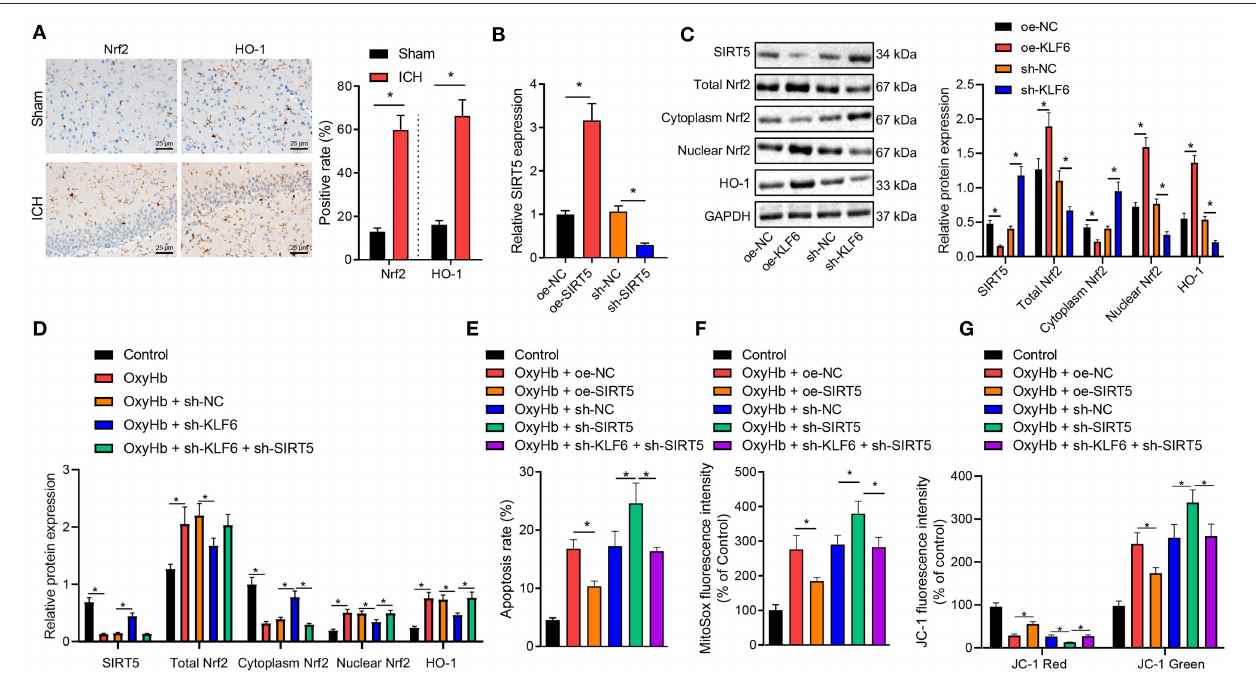
FIGURE 7 | Silencing KLF6 causes inhibition of mitochondrial ROS and mitochondrial damage of OxyHb-induced hippocampal neurons via the SIRT5/Nrf2/HO-1 axis. (A) The expression of Nrf2 and HO-1 in the hippocampus of ICH rats detected by IHC ( n = 6). (B) The expression of SIRT5 in hippocampal neurons after the silencing and overexpression of SIRT5 determined by RT-qPCR. (C) The expression of SIRT5, Nrf2 (total, cytoplasm, and nuclear), and HO-1 in hippocampal neurons after the silencing and overexpression of KLF6 determined by Western blot analysis. (D) The expression of Nrf2 (total, cytoplasm, and nuclear) and HO-1 in hippocampal neurons exposed to 20 µ M OxyHb after the silencing of KLF6 determined by Western blot analysis. (E) OxyHb-induced hippocampal neuronal apoptosis after different infection determined by flow cytometry. (F) The changes of mitochondrial active oxygen determined by MitoSOX fluorescent staining. (G) Changes in mitochondrial membrane potential determined by JC-1 staining. * p < 0.05. The measurement data were expressed as mean ± standard deviation. Comparisons between two groups were analyzed using unpaired t -test, and comparisons among multiple groups were tested by one-way ANOVA followed by Dunnett post-hoc test. The experiment was repeated three